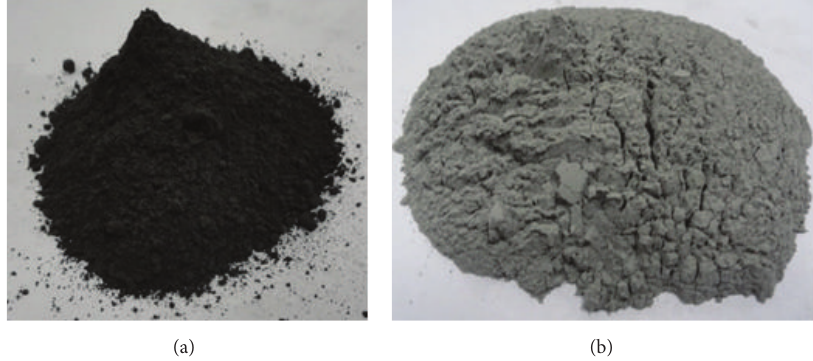
Figure 1: (a) Palm oil fuel ash (POFA) and (b) Fly ash (FA).